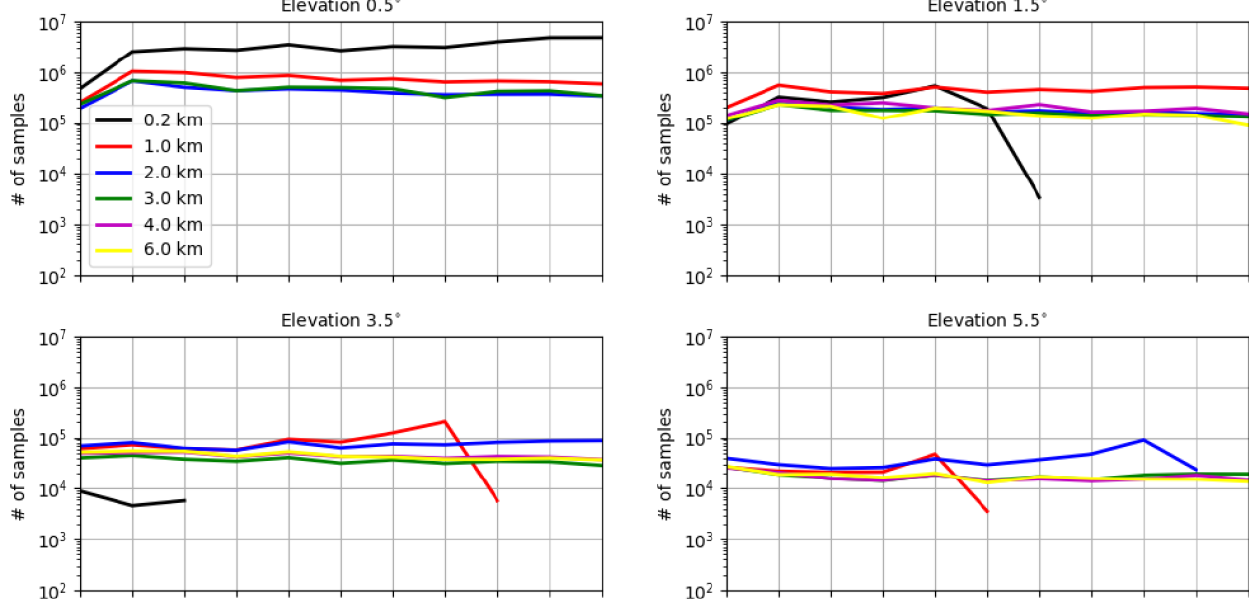
Figure A8. The same as Fig. A7 but for radial wind